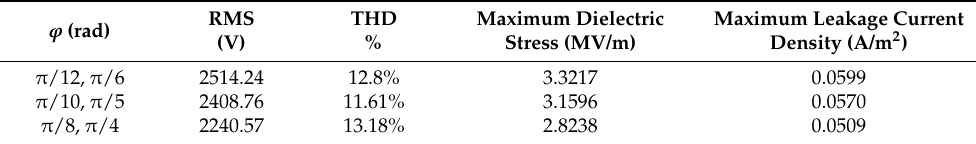
Table 6. Effect of the increase in firing angles for 5-level inverter output.